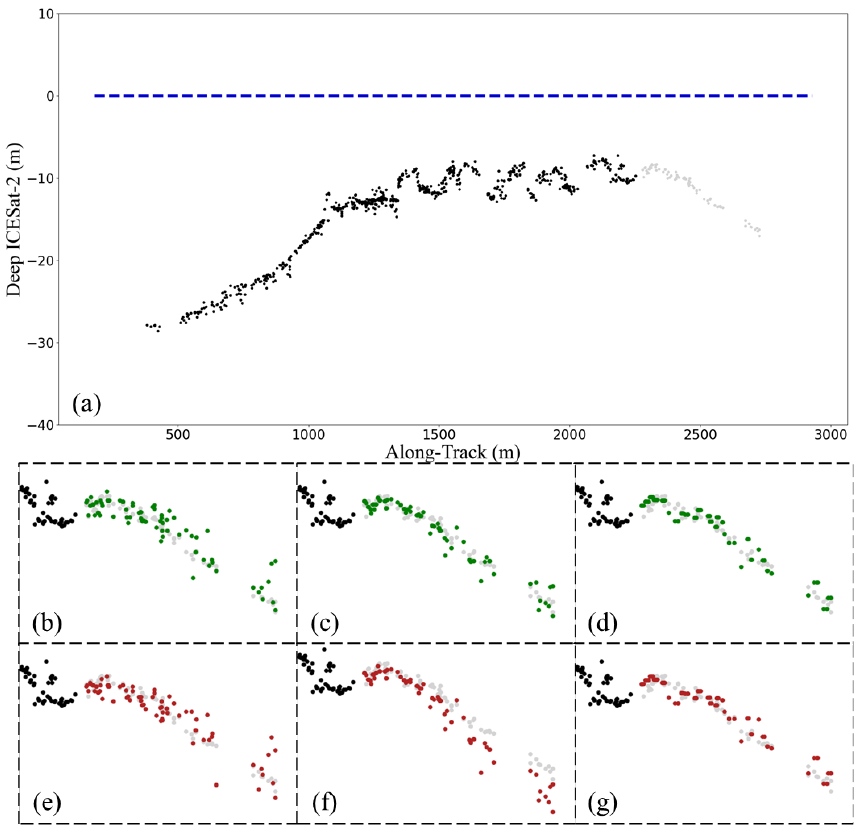
16 of 22 Table 5. The accuracy of the reconstructed bathymetric signals based on remote sensing images with three different spatial resolutions.